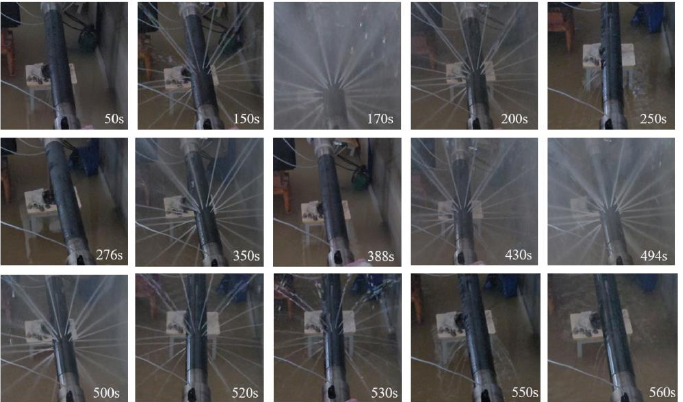
Figure 18. Experimental phenomena of Experiment II and Experiment III.